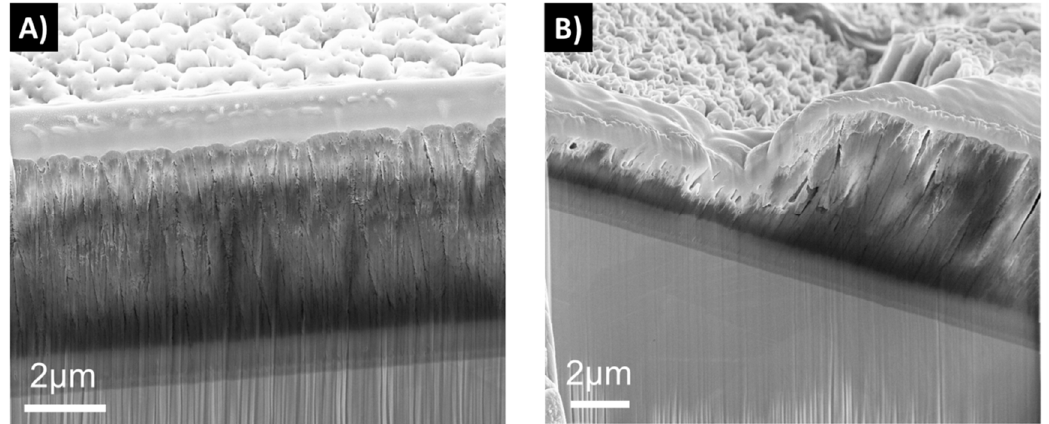
Figure 6. Cross sections from sample 3D-3f-H0-P1.7 before ( a ) and after the ( b ) reciprocal wear test, showing surface morphology and coating layer cross sections.